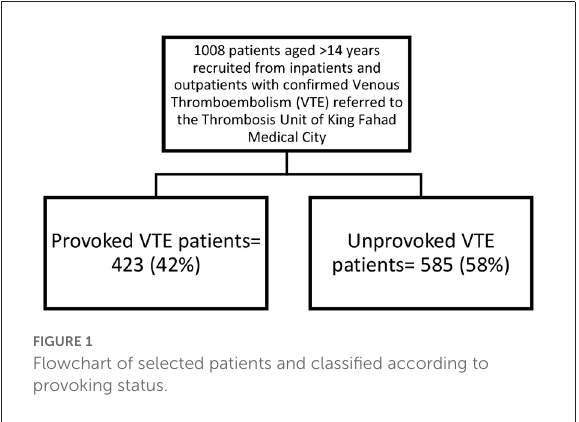
FIGURE1 Flowchart of selected patients and classified according to provoking